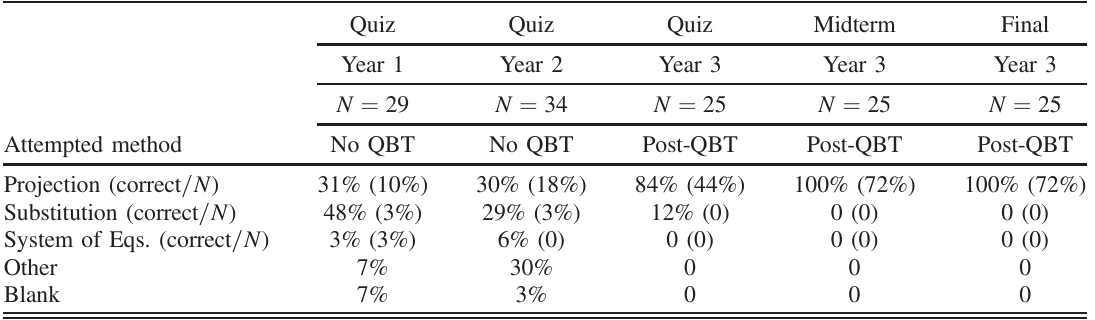
TABLE VII. Methods for changing basis from University B from various assessments over a number of years. Quiz and exam data from years prior to tutorial implementation is replicated from previous tables for